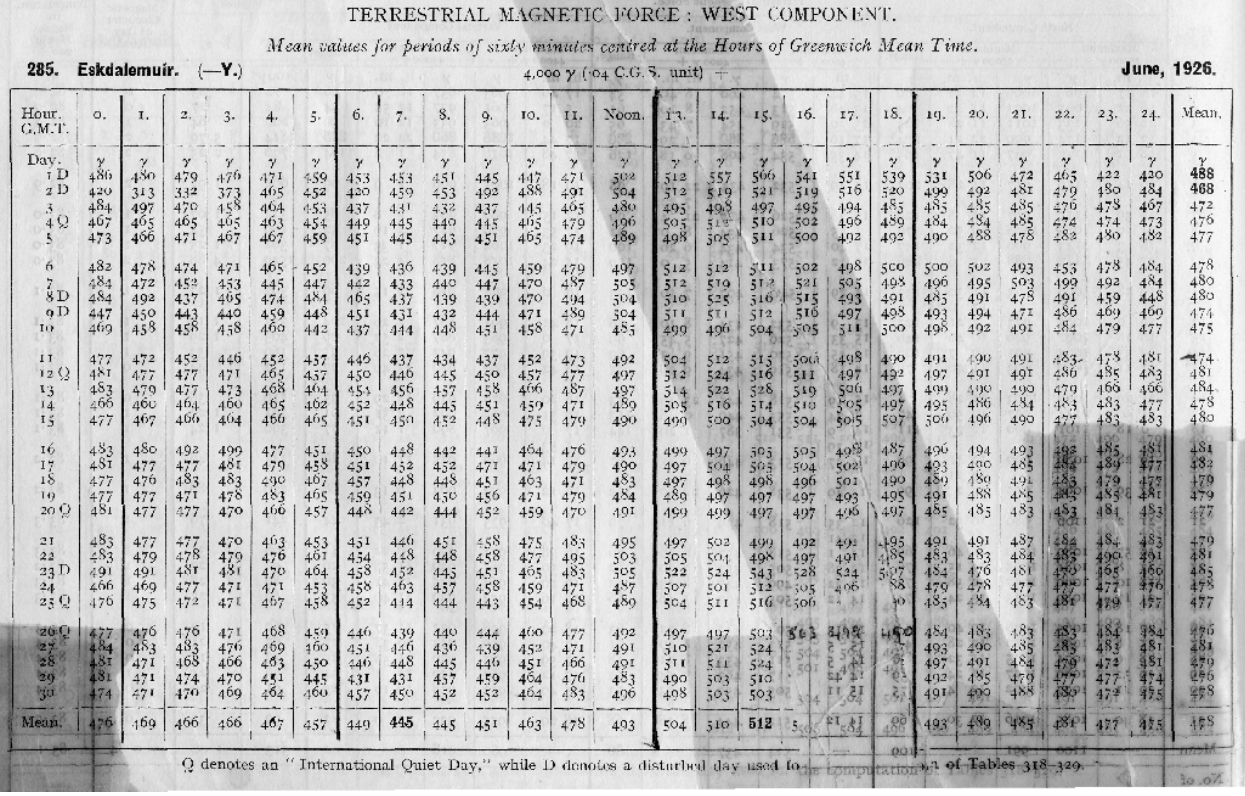
Fig. 2. Example of a TIFF file of a monthly table of hourly values scanned from the ESK yearbooks. This illustrates the typical poor quality of the original